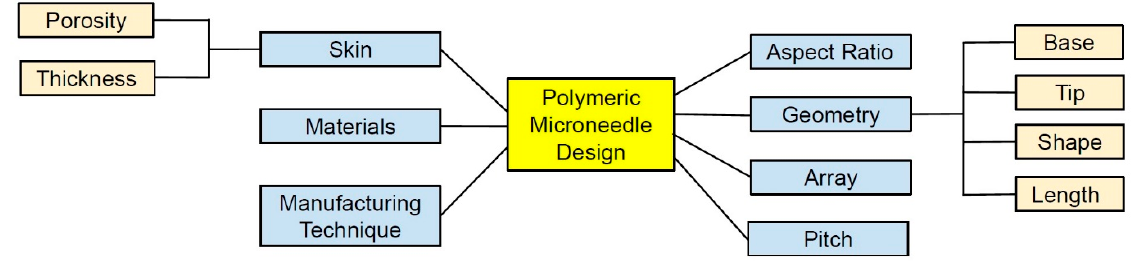
Figure 3. Several parameters affecting the design and performance of polymeric MNs.